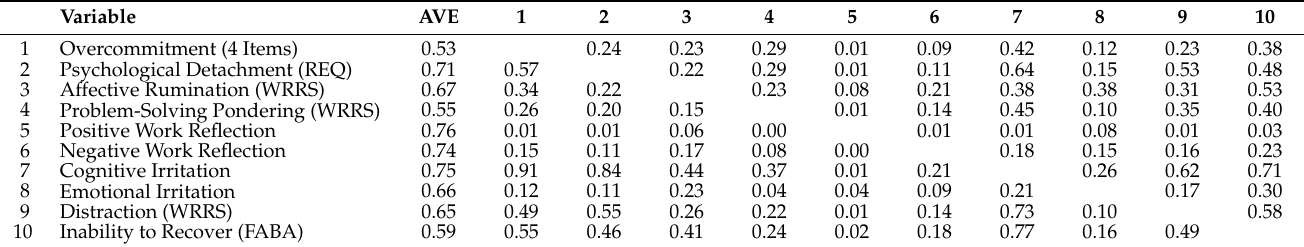
Table 7. Average Variance Extracted and Squared Correlations Among Variables in Sample